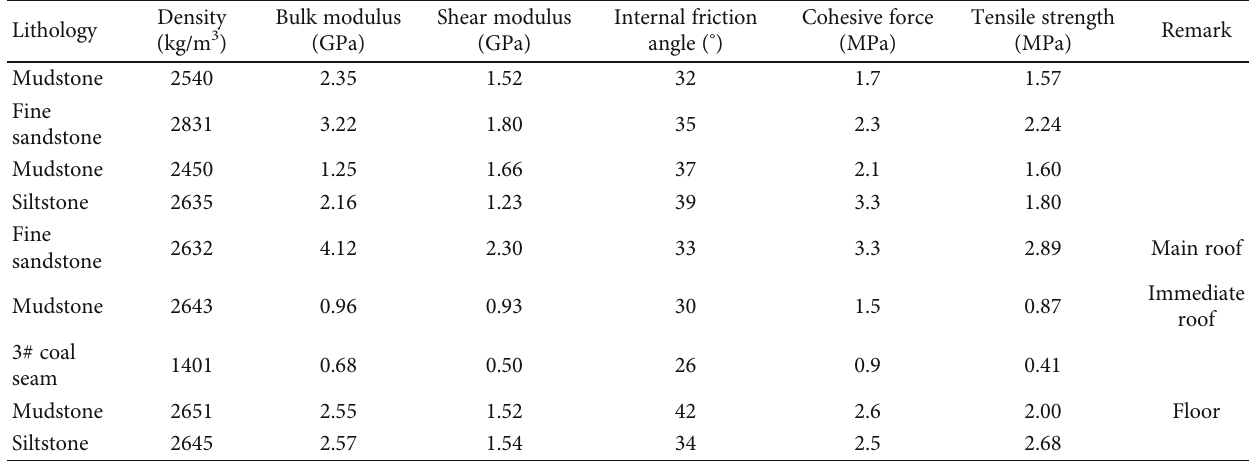
Figure 3: Layout and failure characteristics of roadway: (a) the roadway layout of the 5306 coalface; (b) area of 20 m in front of the workface; (c) area of 35m in front of the workface. Table 1: Physical and mechanical parameters of rock